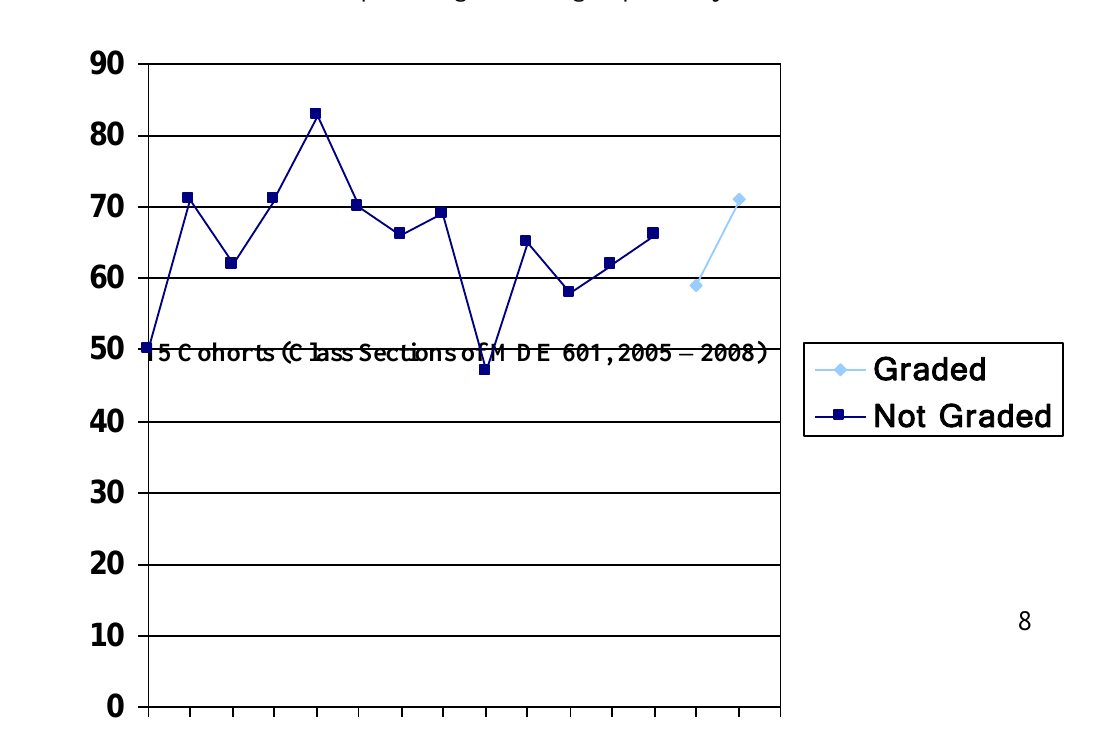
Figure 2 : MDE 601 – Module 4 as a percentage of total group